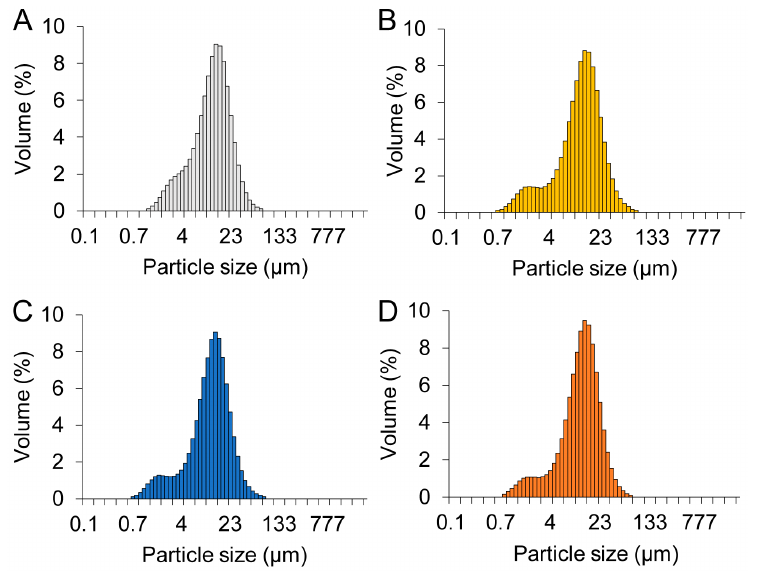
Figure 3. Particle size distribution (PSD) of the four glass particles. ( A ) Cont, ( B ) PG-1, ( C ) PG-2, and ( D ) PG-3. Table 1. Elemental compositions of Cont, PG-1, PG-2, and PG-3 glasses (mol%) via XRF analysis.